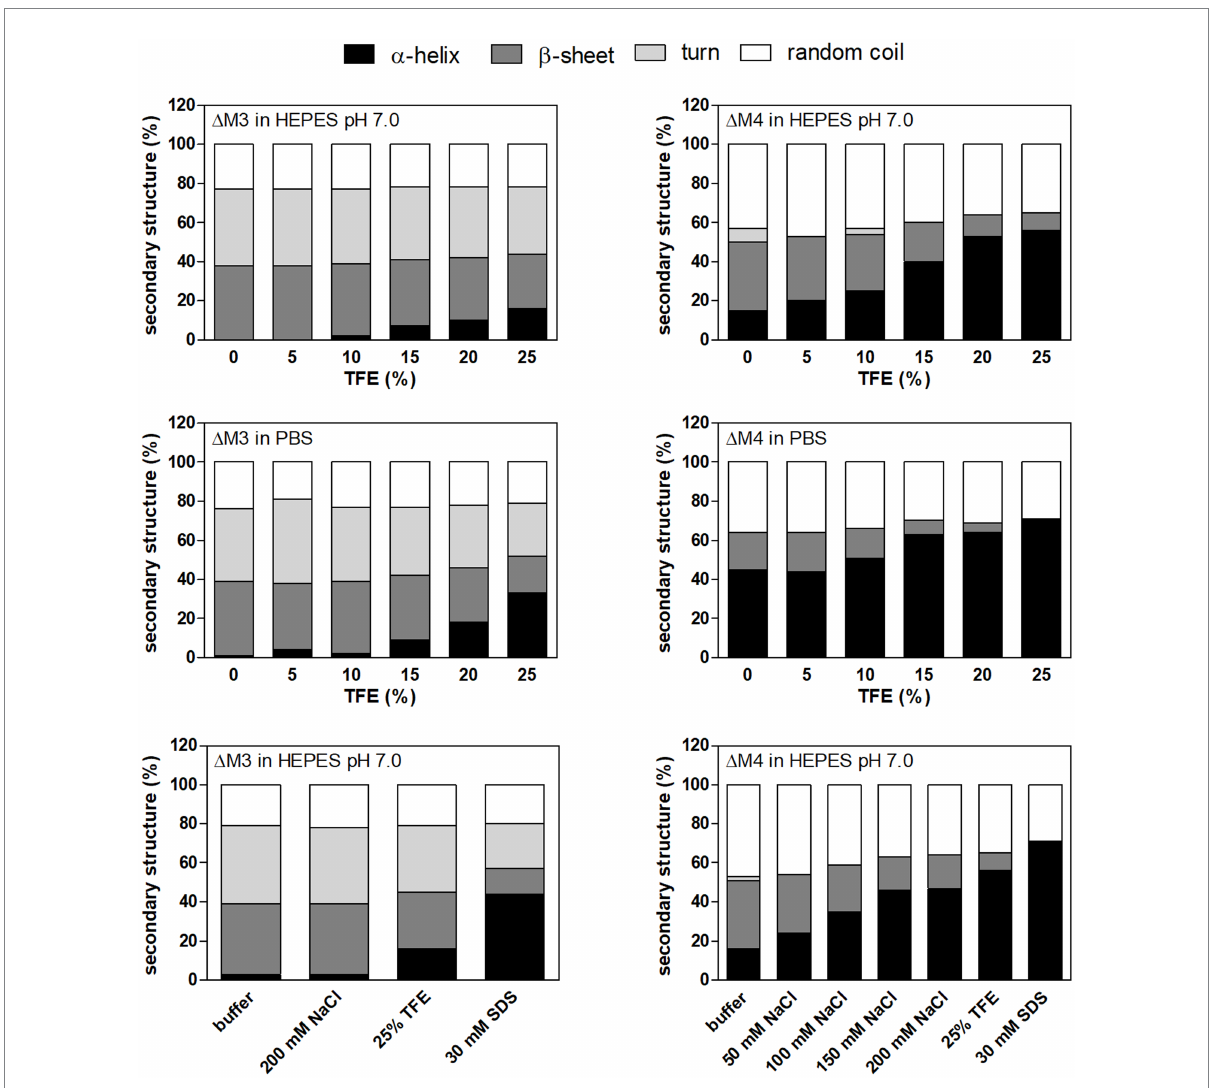
FIGURE 3 The secondary structure of peptides in different solutions analyzed by circular dichroism (CD) measurements. Δ M3 and Δ M4 peptides (both at a concentration of 1 mg/ml) were prepared in 10 mM HEPES pH 7.0 or PBS. Trifluoroethanol (TFE) at a final concentration in a range of 5–25% was used to enhance secondary structure stability. To check the effect of NaCl on the secondary structure of the peptides, samples were prepared in 10 mM HEPES pH 7.0 with NaCl (50–200 mM). Buffer supplemented with 30 mM SDS was used to mimic microbial membrane. CD spectra of peptides were measured in the range of 195–250 nm and averaged over five acquisitions. Secondary structure content was determined using JSSE program (Jasco) using CD spectra of α -chymotrypsin A, hemoglobin, lysozyme, myoglobin and ribonuclease A proteins as a